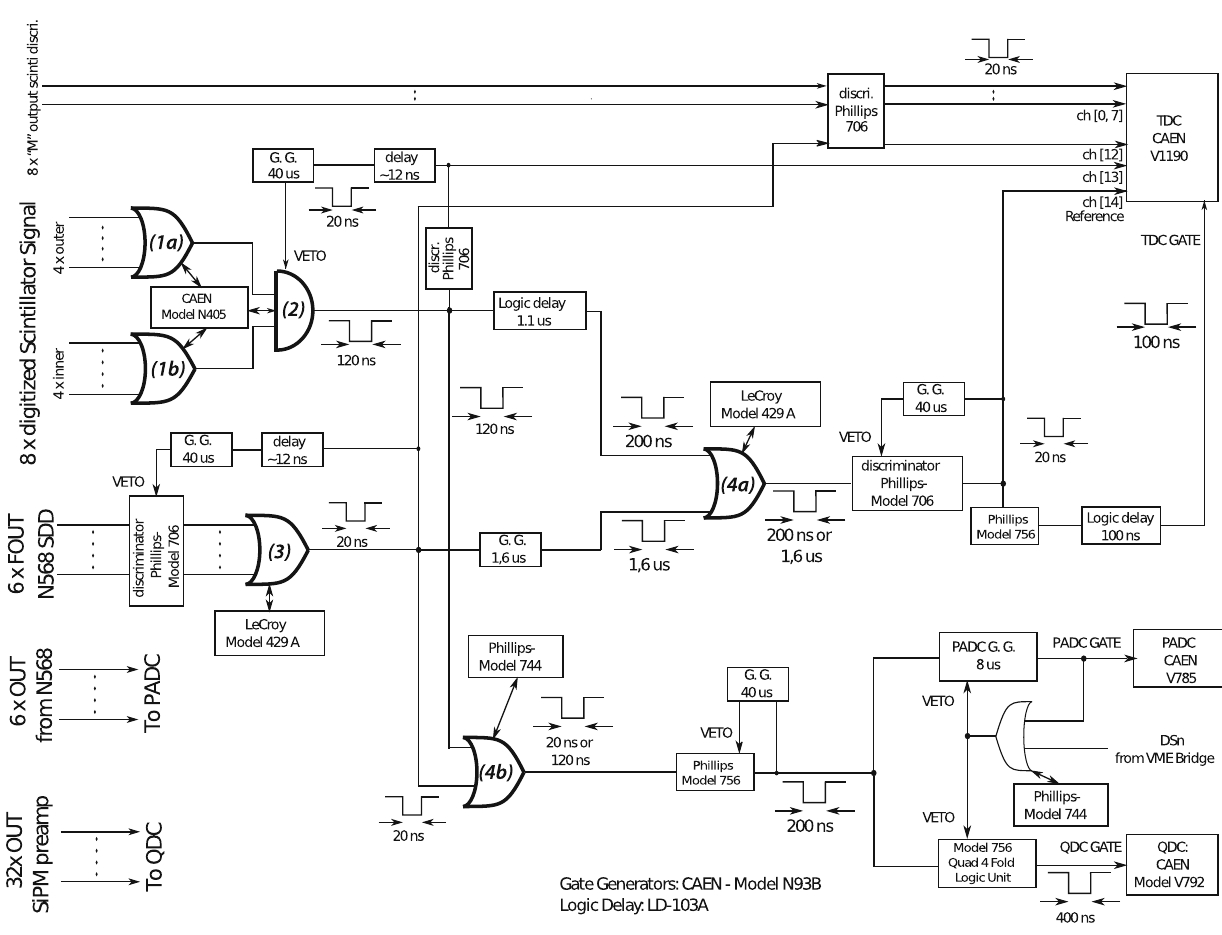
Fig. 5 The diagram of the trigger logic. The essential parts are highlighted with explanations in the